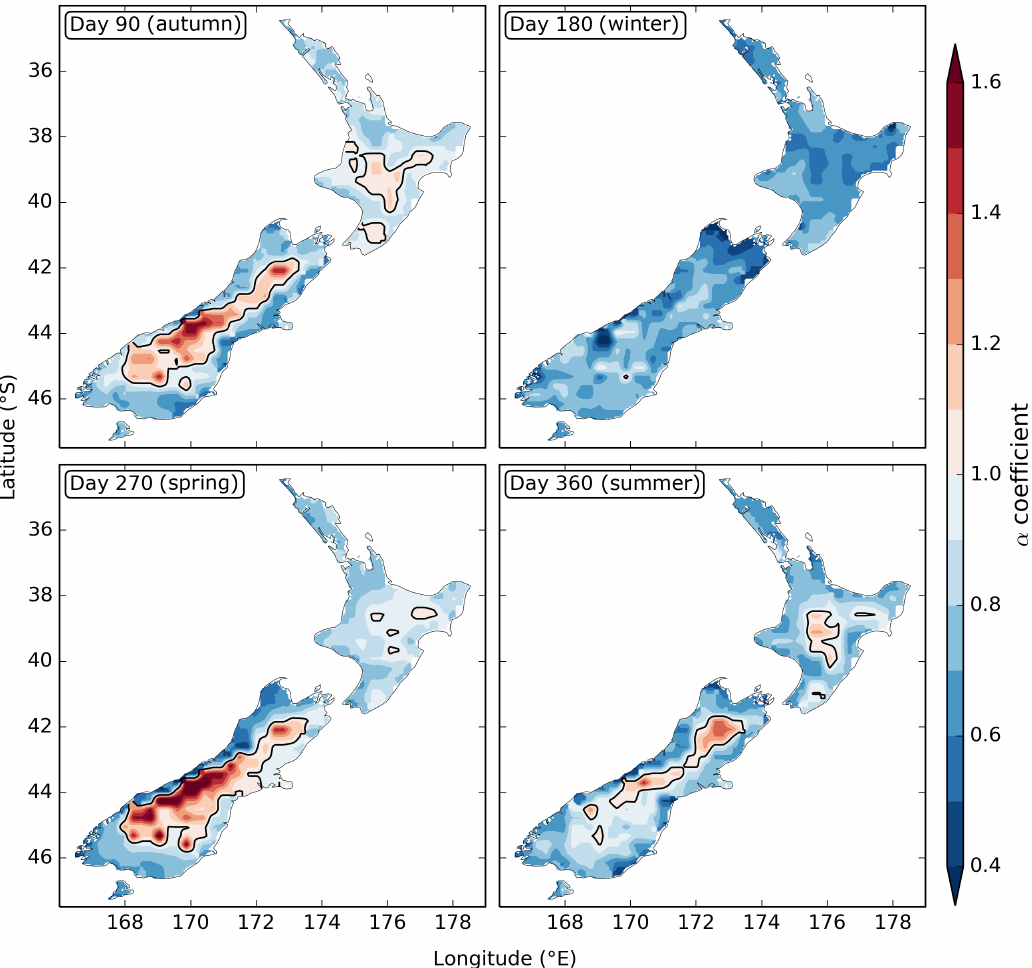
Figure 5. Maps of α coefficients (unitless), which represent the sensitivity of changes in daily maximum surface temperature to changes in annual mean global mean surface temperatures for locations throughout New Zealand. The α coefficients were derived from fits of Eq. (2) to daily time series of daily maximum temperatures at each grid point of the NorESM1-M RCM simulation. The annual mean global mean surface temperature anomalies were taken from the AGCM simulation that provided the boundary conditions for this particular RCM simulation. Black lines indicate α values of